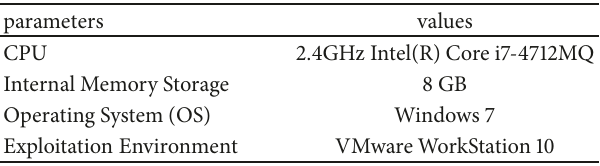
Table 1: The experimental environment.